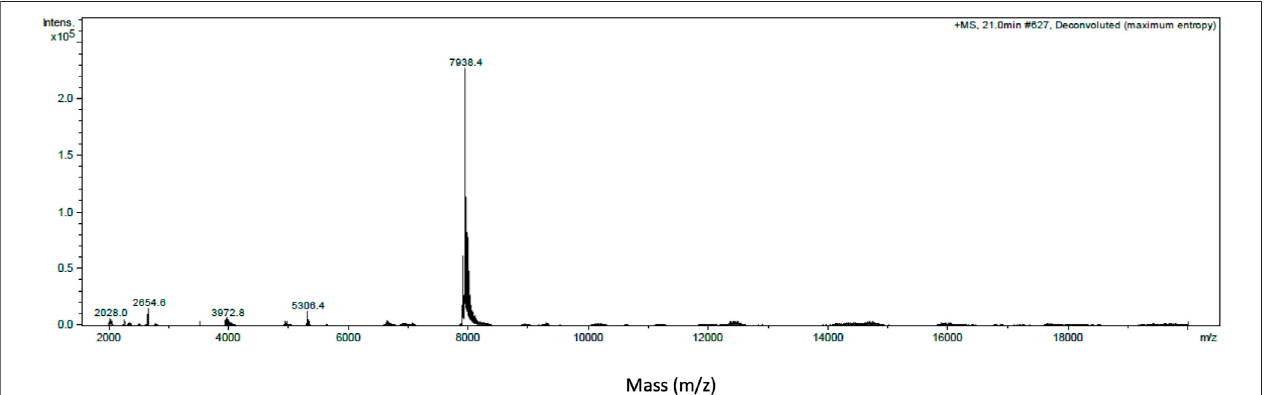
FIGURE 3 | Intact protein MALDI-TOF chromatogram of α -Elapitoxin-Oh3a indicating an intact mass of 7,938.4 Da.